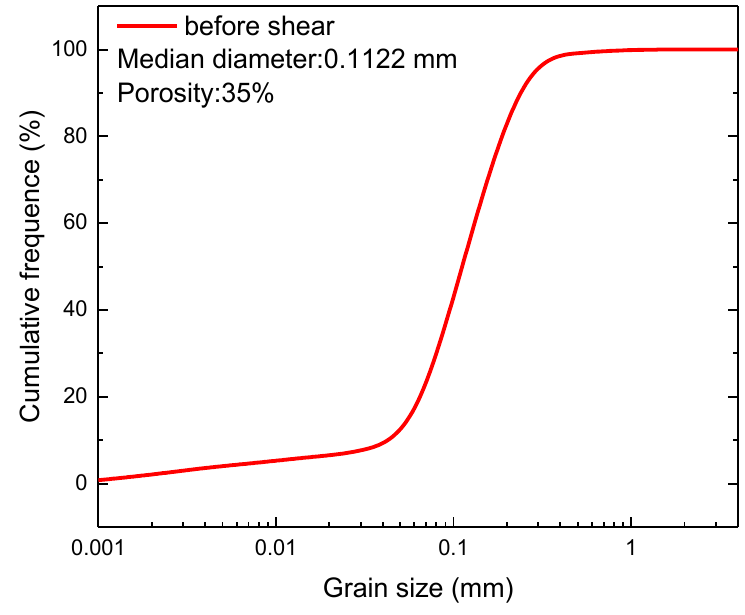
Figure 2. The grain size (mm) distributions of the host sand.